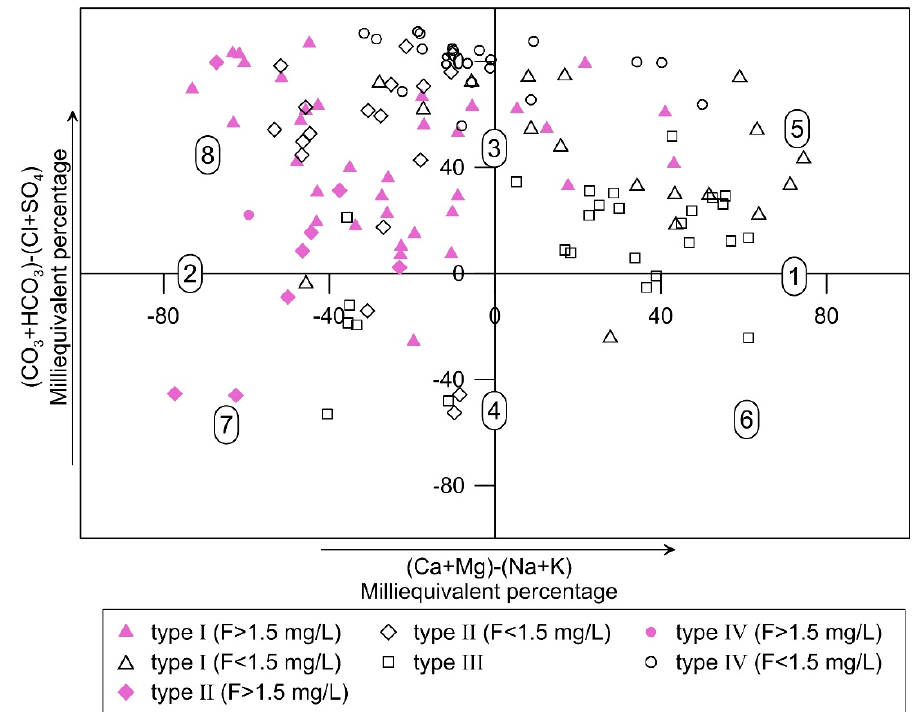
Figure 5. Chadha’s plot showing hydrochemical classification of groundwater. 1. Alkaline